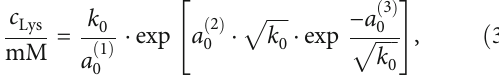
Table S.2 in the Supplementary Materials and symbols in Figure 5. The obtained parameters are summarized in Table 1. As represented by the lines in Figure 5, an